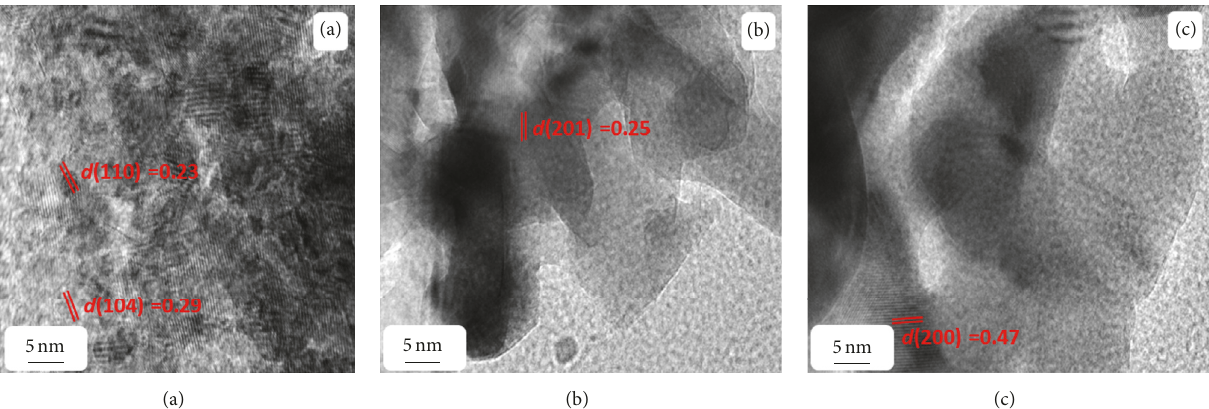
Figure 5: The HRTEM images of catalyst calcined at different temperatures: (a) 1% ZnO ZnO –Mn 2 O 3 . x